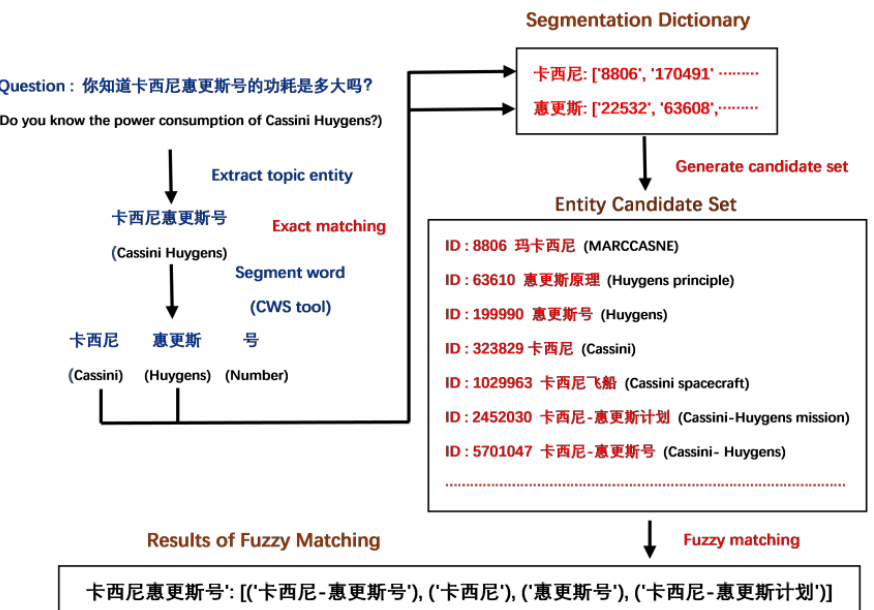
Figure 6. The workflow of the fuzzy matching module. The input query is “ 你 知 道 卡 西 尼 惠 更 斯 号 的 功 耗 是 多大 吗 ” (Do you know the power consumption of Cassini–Huygens?). The topic entity extracted by the NER model is “ 卡 西 尼 惠 更 斯 号 ” (Cassini–Huygens). However, the entity “ 卡 西 尼 惠 更 斯 号 ” (Cassini–Huygens) cannot be retrieved in the knowledge base. Therefore, we put it into the fuzzy matching module for further processing. After processing, the correct entity “ 卡 西 尼 - 惠 更 斯 号 ” (Cassini–Huygens) with the highest similarity to it is included in the candidate results. At the same time, three related entities with high similarity are also included in the candidate results, which improves the robustness of the